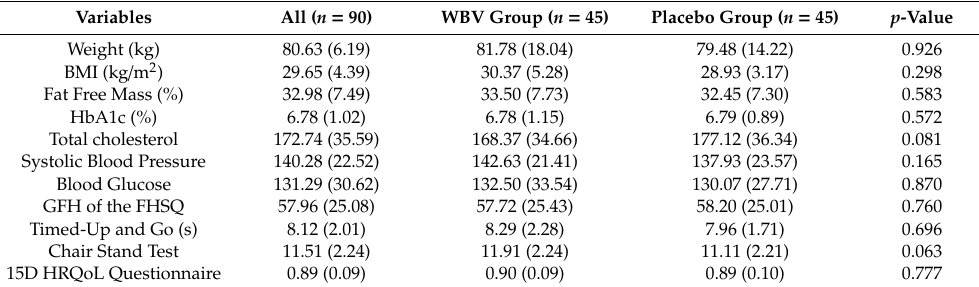
Table 2. Baseline characteristics of the study participants.